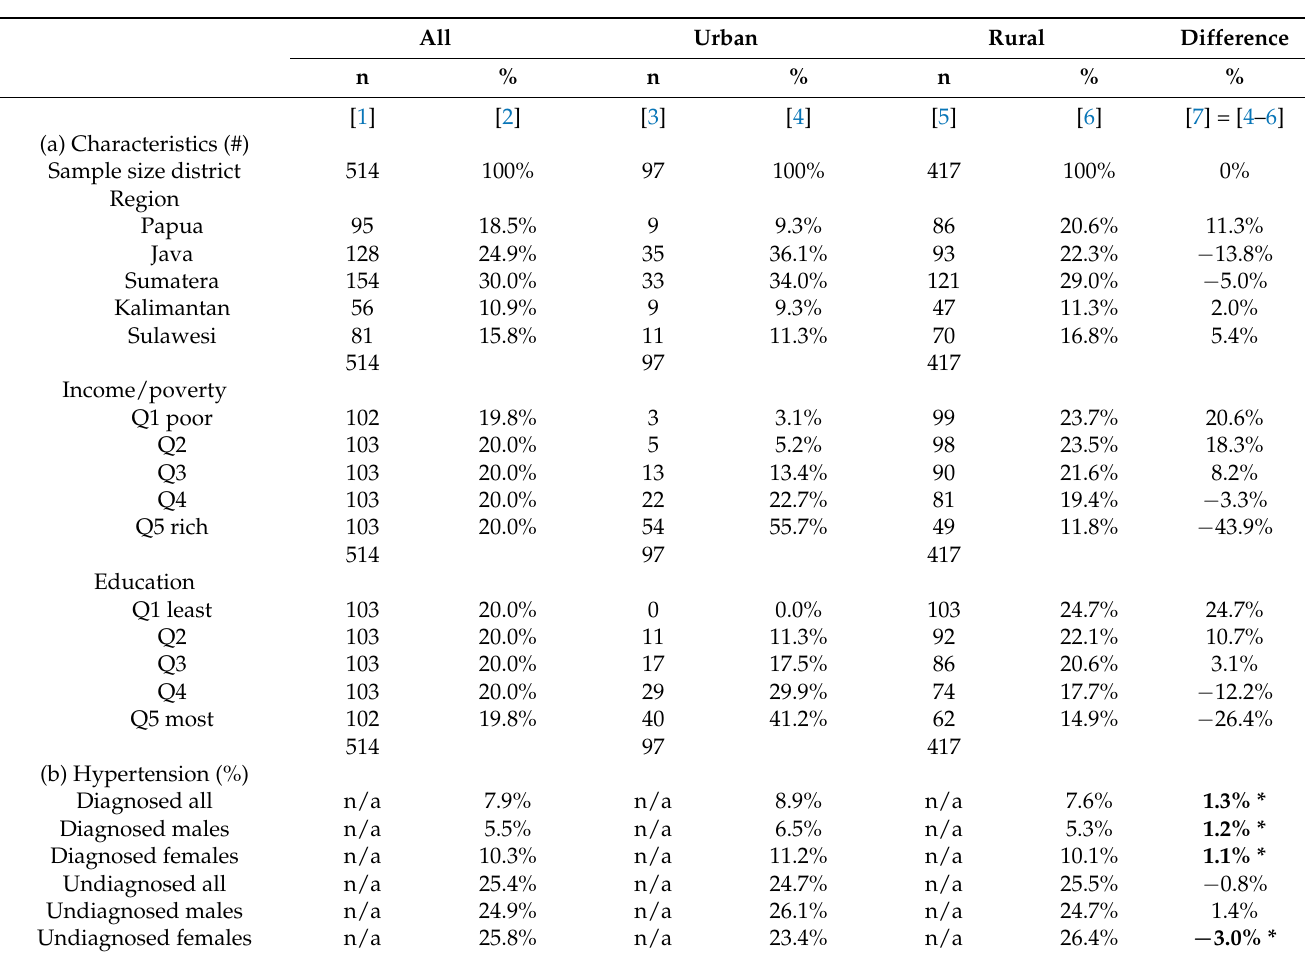
Table 2. Characteristics of districts and hypertension (diagnosed and undiagnosed) among adults (18+ years) in Indonesia, 2018.